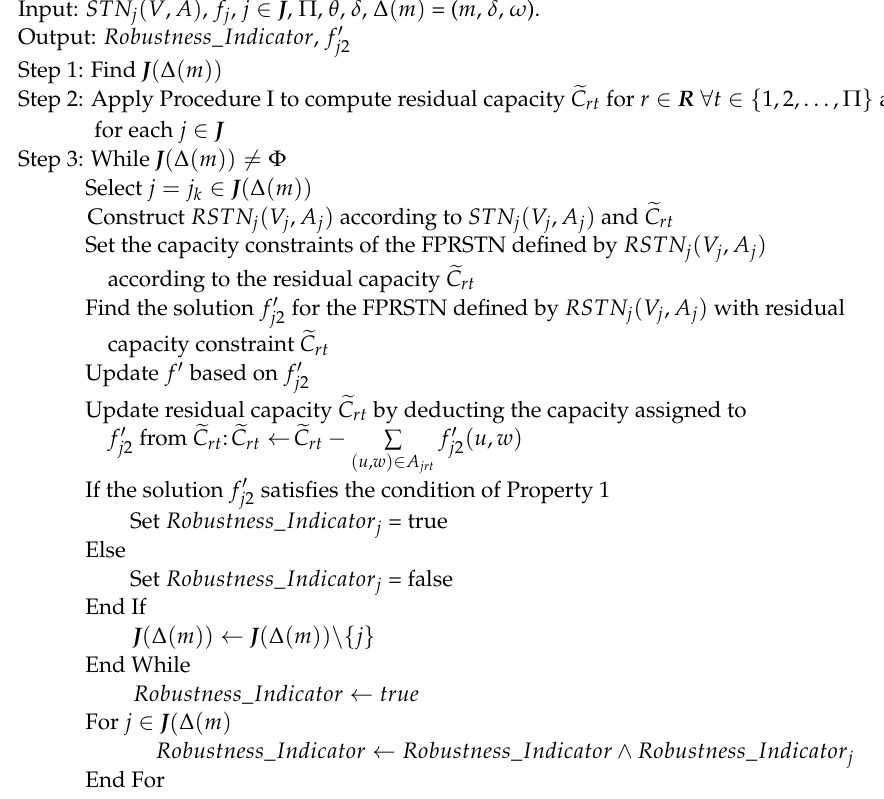
Algorithm 3: Check Robustness with respect to Uncertainty ∆ ( m